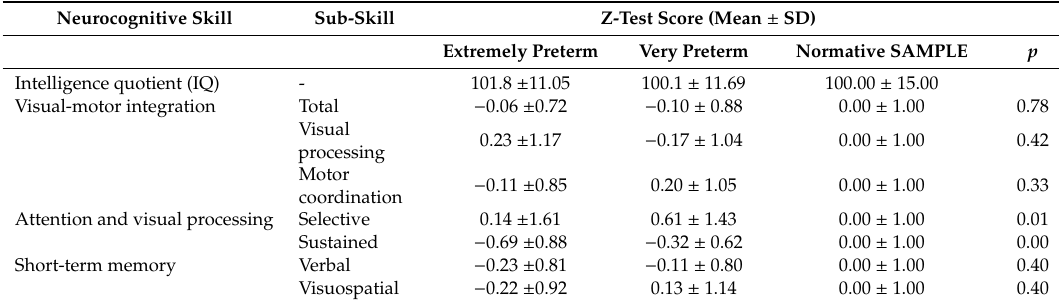
Table 4. Summary of the neurocognitive skills for the extremely preterm and very preterm children. Neurocognitive